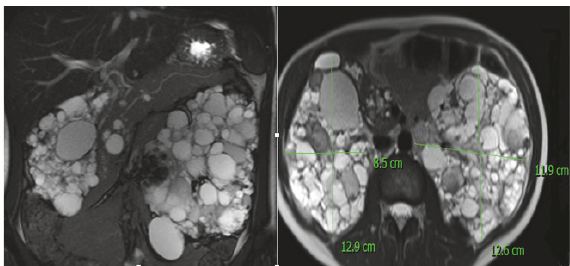
Figure 1: Polycystic kidneys with bilateral renal angiomyolipomas.